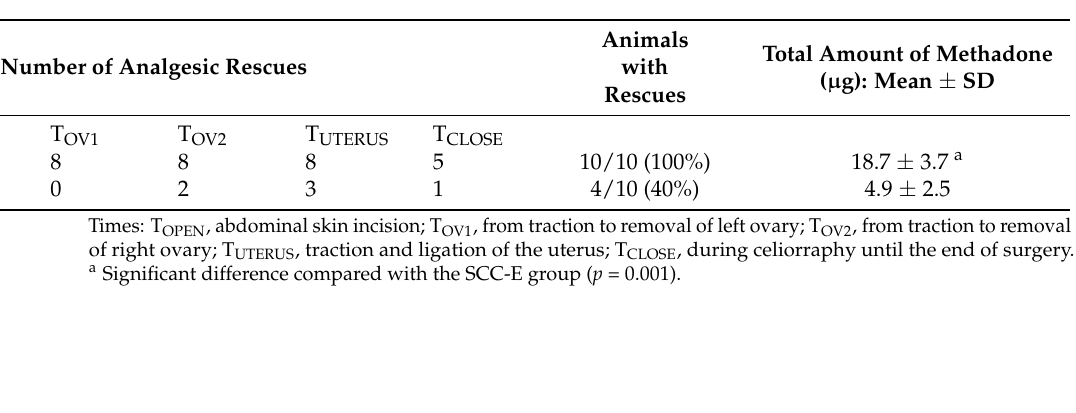
Figure 3. Mean arterial pressure (MAP) in cats undergoing ovariohysterectomy with (SCC-E group) or without (CTR group) sacrococcygeal epidural ( n = 10 in each group). Times: T BASELINE , prior to skin incision; T OPEN , abdominal skin incision; T OV1 , from traction to removal of the left ovary; T OV2 , from traction to removal of the right ovary; T UTERUS , traction and ligation of the uterus; T CLOSE , during celiorraphy until the end of surgery. The horizontal line inside the boxes denotes the median value, while the upper and lower whisker bounds denote the maximum and minimum values. The boxes show the interquartile ranges. a Significant difference compared with T BASELINE ( p -values were 0.018 and 0.012 for T OV1 and T OV2 , respectively). b Significant difference compared with group SCC-E ( p -values were 0.021 and 0.019 for T OV1 and T OV2 , respectively). Comparing groups for each surgical period, HR was significantly higher in the group CTR in T OV1 , T OV2 , T UTERUS, and T CLOSE compared with group SSC-E (Figure 1). The same occurred for SAP and MAP during T OV1 and T OV2 (Figures 2 and 3).